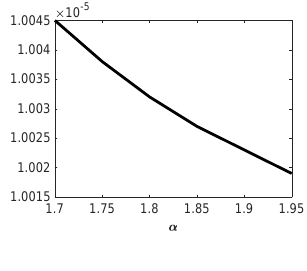
Figure 3. The absolute maximum error of w ( x,t ) for different α in example 1. T = 0 . 1 and ∆t = 10 − 4 are